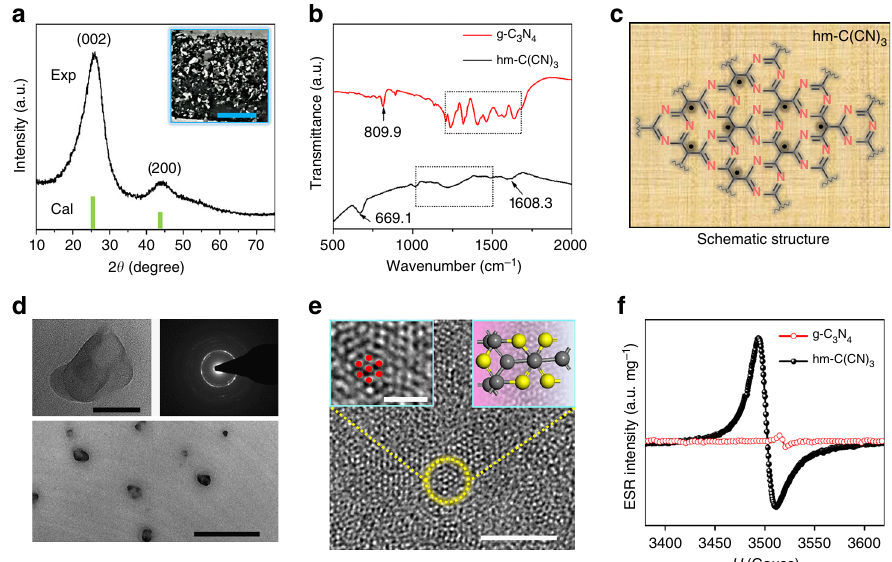
Fig. 1 Characterization of hm-C(CN) 3 . a XRD patterns of the bulk hm-C(CN) 3 materials (Scale bar, 1 cm). b FTIR spectra of g-C 3 N 4 and bulk hm-C(CN) 3 . c Schematic representation of chemical structure for hm-C(CN) 3 material. d Top panel: applied TEM image (Scale bar, 20 nm) and SAED pattern of R@hm- C(CN) 3 nanosheets. Bottom panel: TEM image of R@hm-C(CN) 3 nanosheets (Scale bar, 200 nm). e HR-TEM image of R@hm-C(CN) 3 nanosheets (Scale bar, 2 nm). Left inset: locally ampli fi ed HR-TEM image (Scale bar, 1 nm). Right inset: atomic structural model. f ESR spectra of g-C 3 N 4 and hm-C(CN) 3